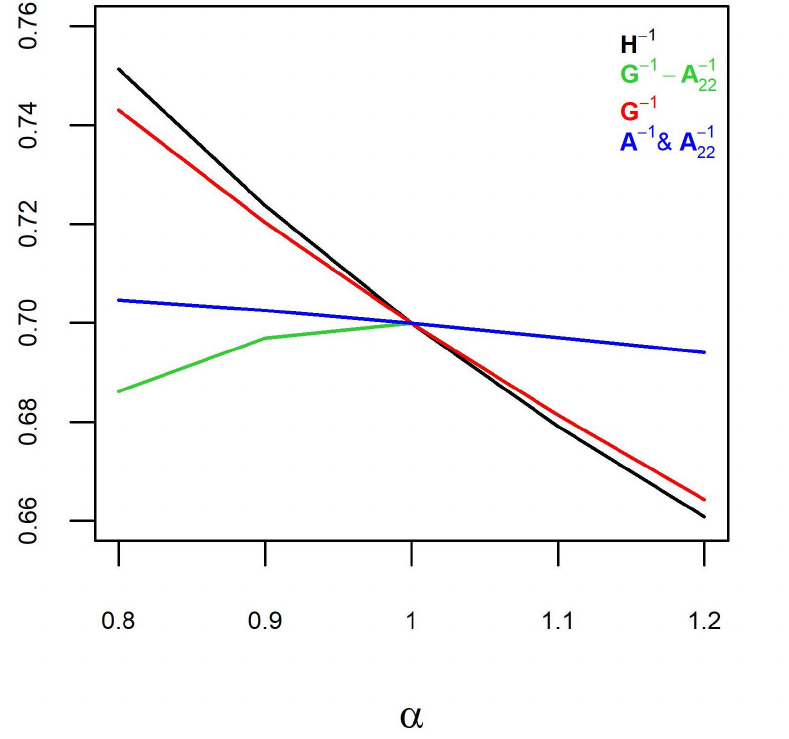
Figure 1. Regression coefficients of the phenotypes on genomic breeding values for different components of H − 1 weighted by α . Each data point is an average of ten observations for the simulated